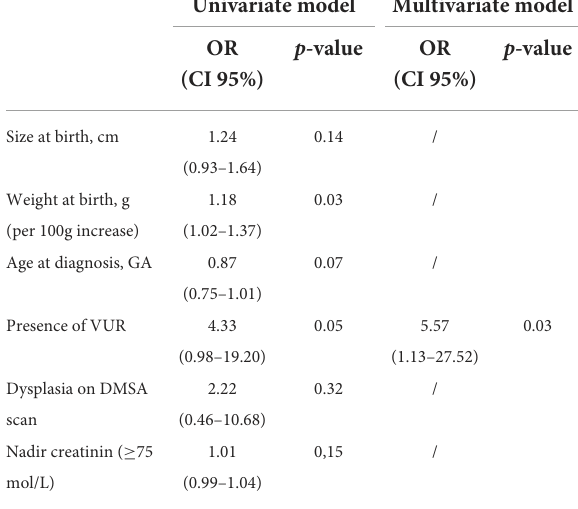
TABLE 3 Factors associated with risk of